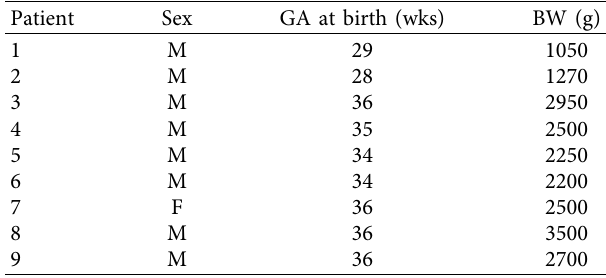
Table 1: Baseline demographic